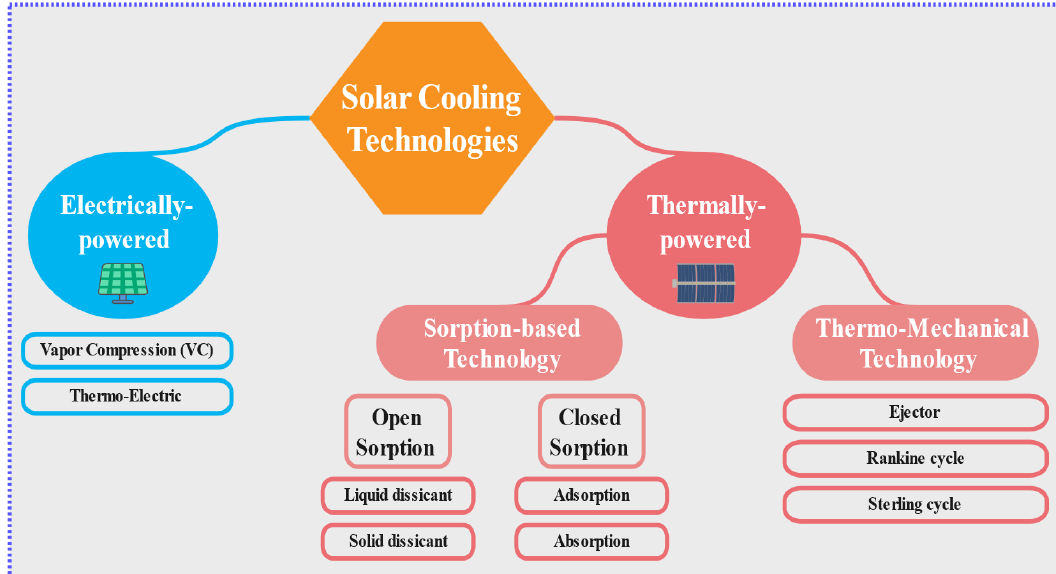
Figure 1. Main solar cooling technologies.